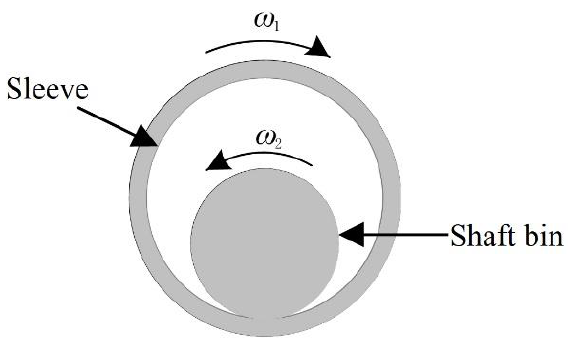
Figure 3. Schematic diagram of the relative movement of the rotating pair.